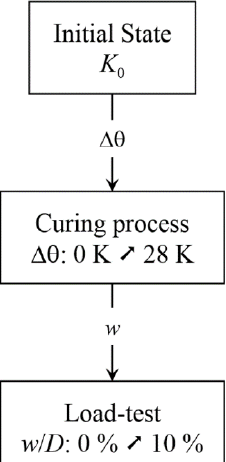
Figure 7. General scheme of the